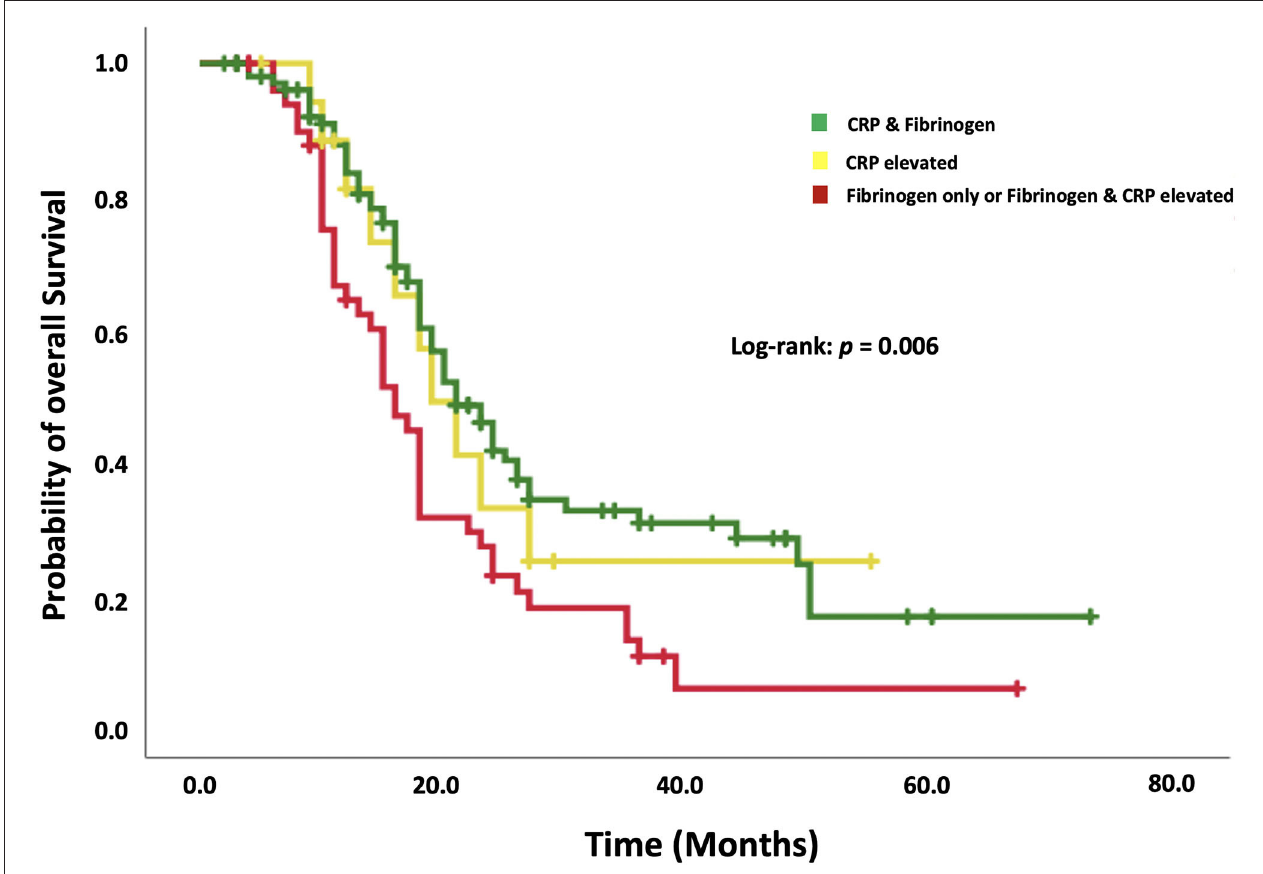
FIGURE 3 | Kaplan–Meier analysis of the survival probability stratified by “normal CRP and fibrinogen,” “increased CRP only,” and “increased fibrinogen with or without increased CRP.” Censored patients (alive at last follow-up) are indicated on the curves. The time axis is right-censored at 80 months. p = 0.006 (log-rank test).